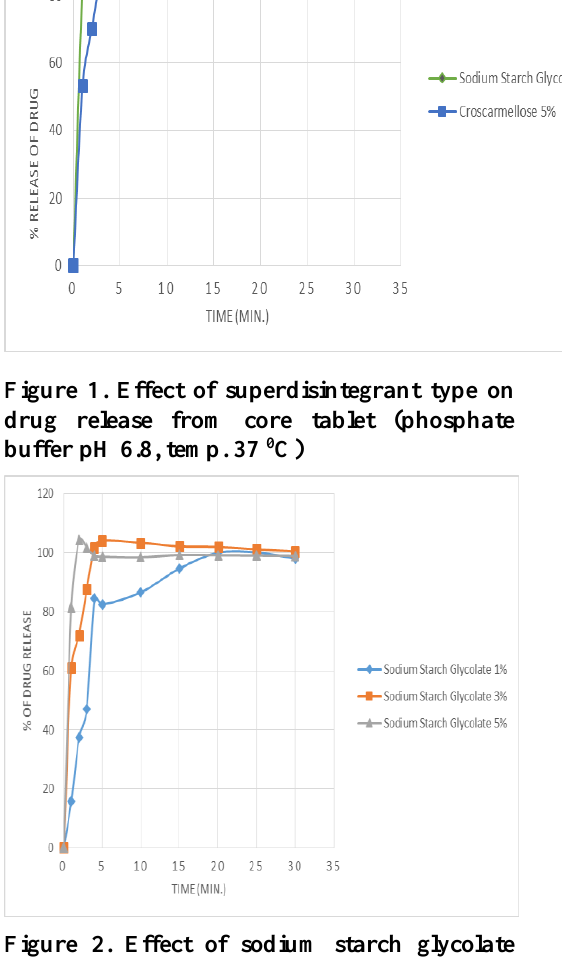
Figure 2. Effect of sodium starch glycolate concentration on drug release from sumatriptan core tablet (phosphate buffer pH 6.8, temp. 37 0